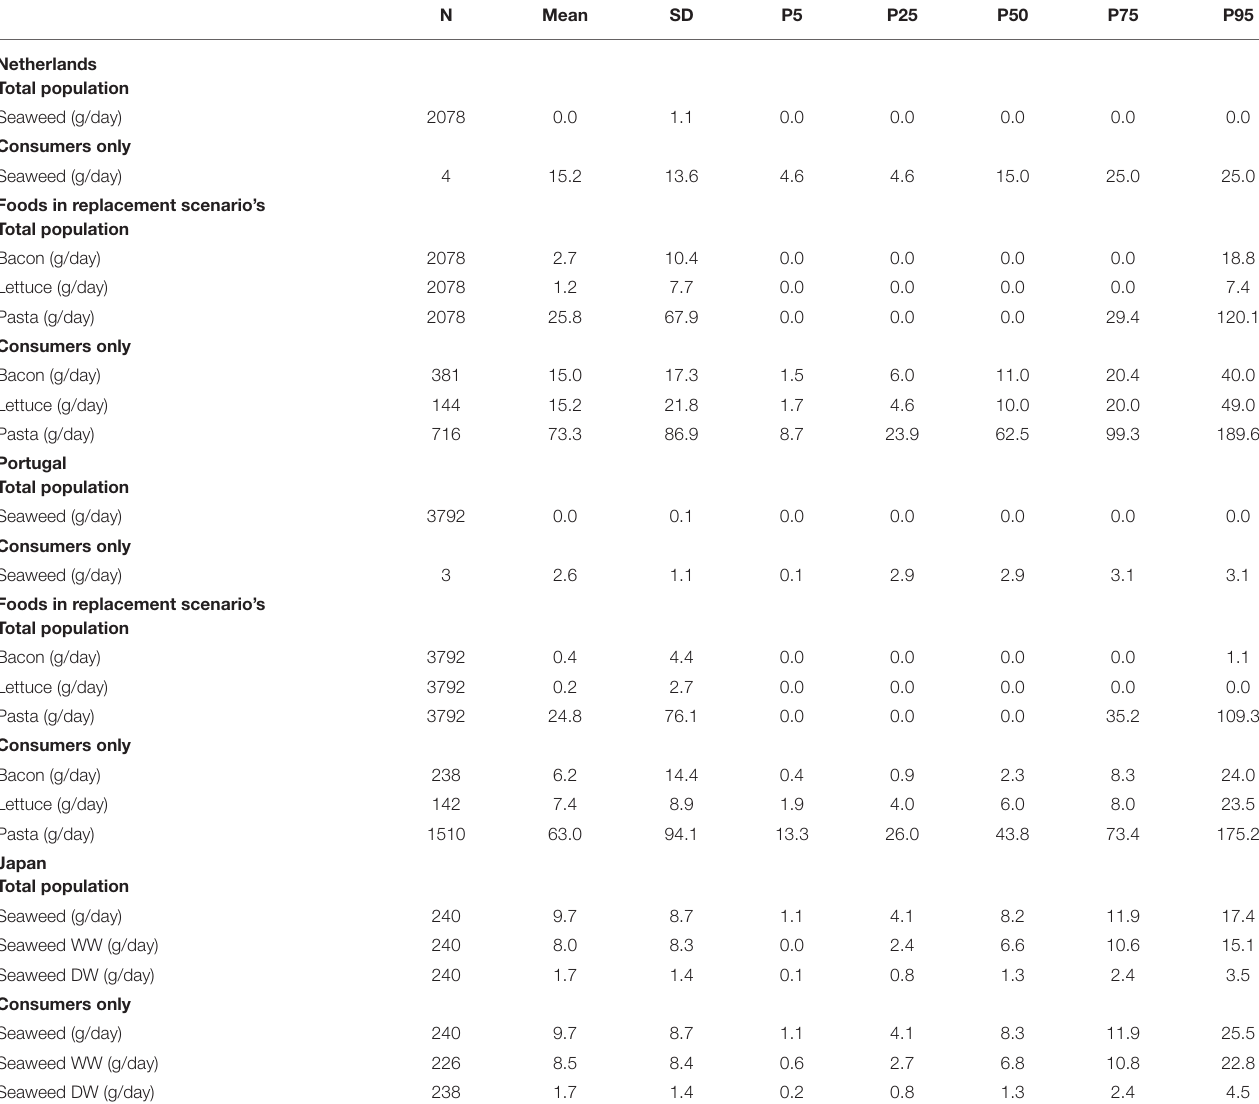
TABLE 4 | The daily average consumption of seaweed, bacon, lettuce in grams per day for Dutch, Portuguese, and Japanese adults’ total study population and consumers only. N Mean SD P5 P25 P50 P75